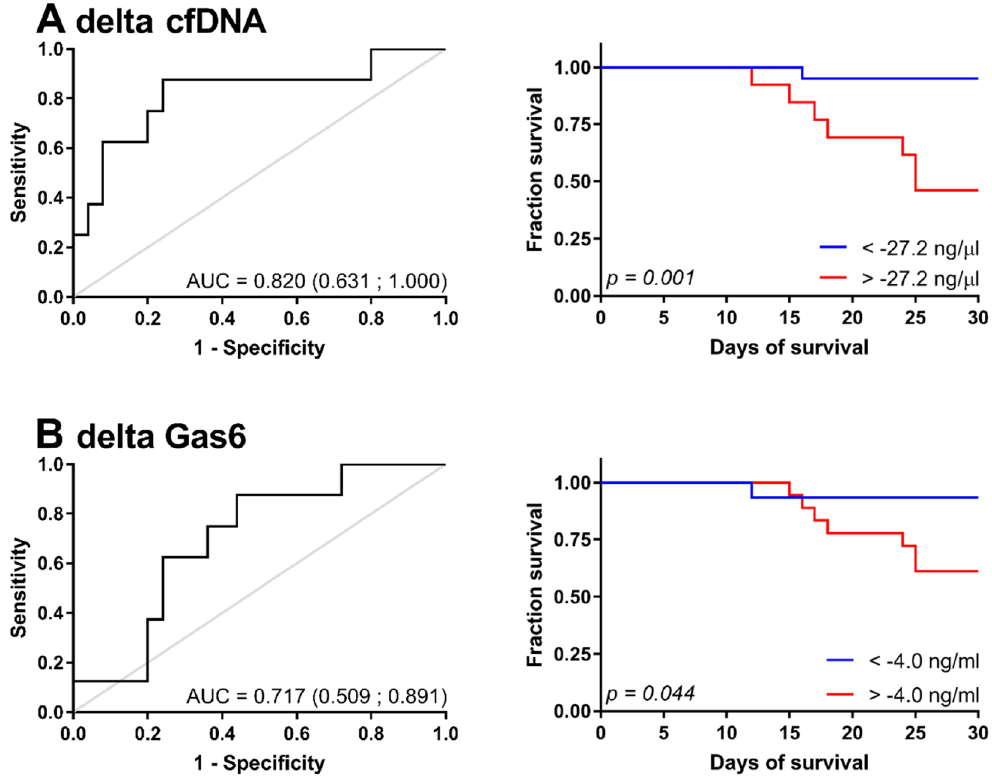
Figure 5. Ideal cutoff value and Kaplan–Meier curves for the prediction of 30-day survival based on sequential levels of ( A ) cfDNA and ( B ) Gas6. Receiver operating characteristic (ROC) curve analysis identified the ideal cut-off value with the Youden index of the difference in cfDNA and Gas6 levels in plasma between the early and late time group (n = 33). Kaplan–Meier survival curves for 30-day survival were created based on the identified cutoff value. P-value was calculated with the Mantel-Cox